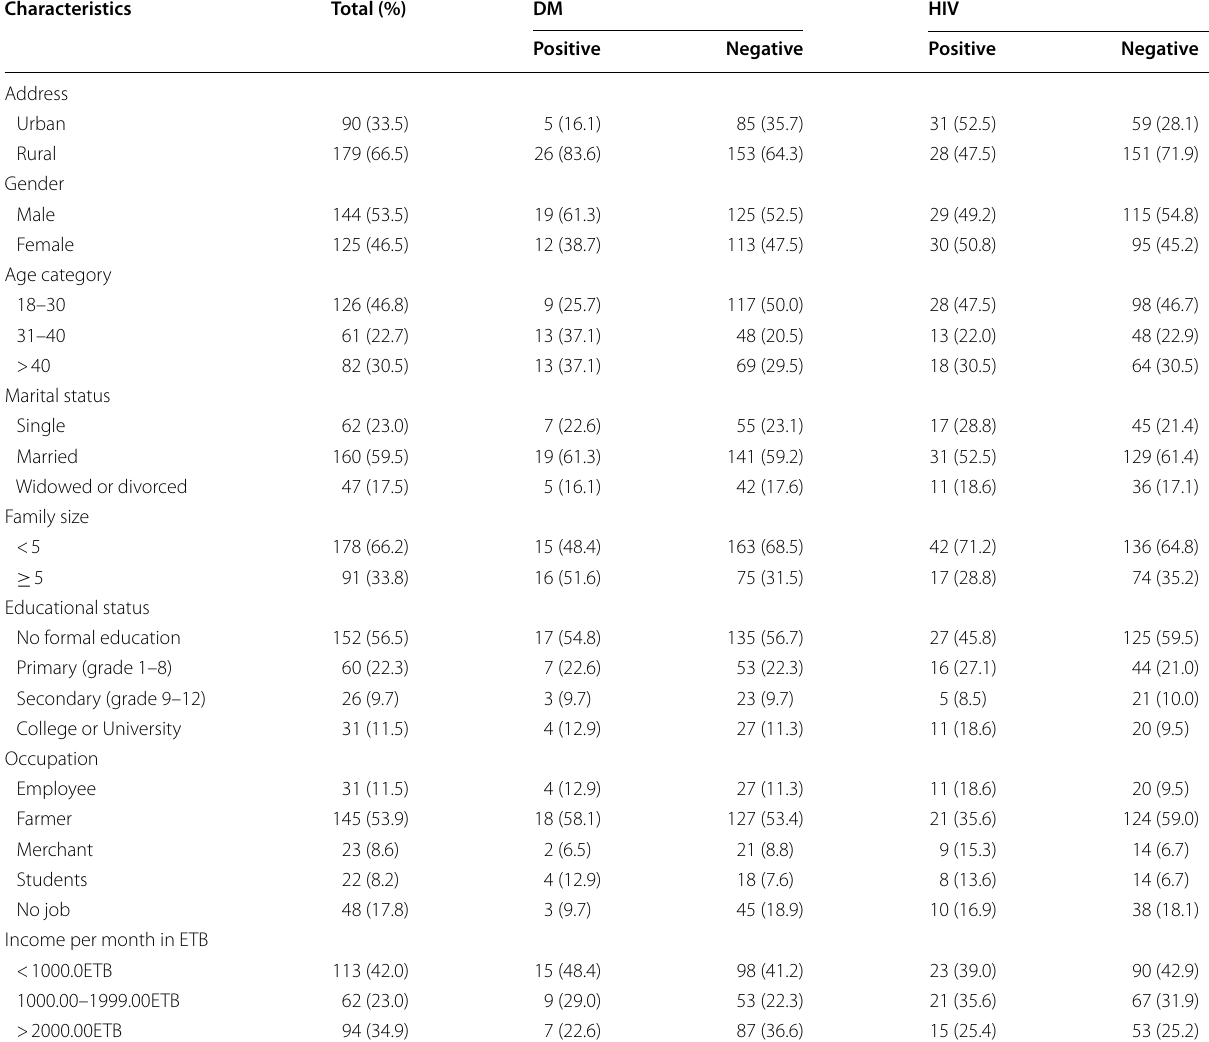
Table 1 Socio-demographic characteristics of the study